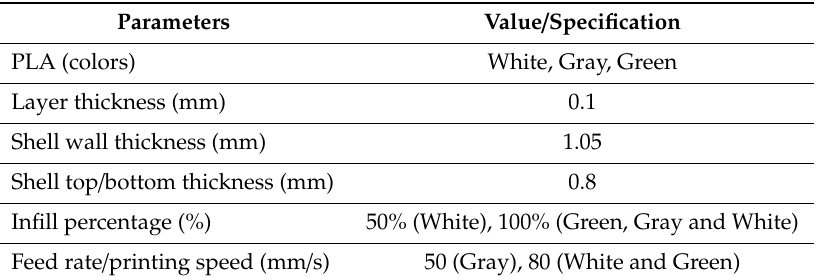
Table 2. Process parameters for FDM